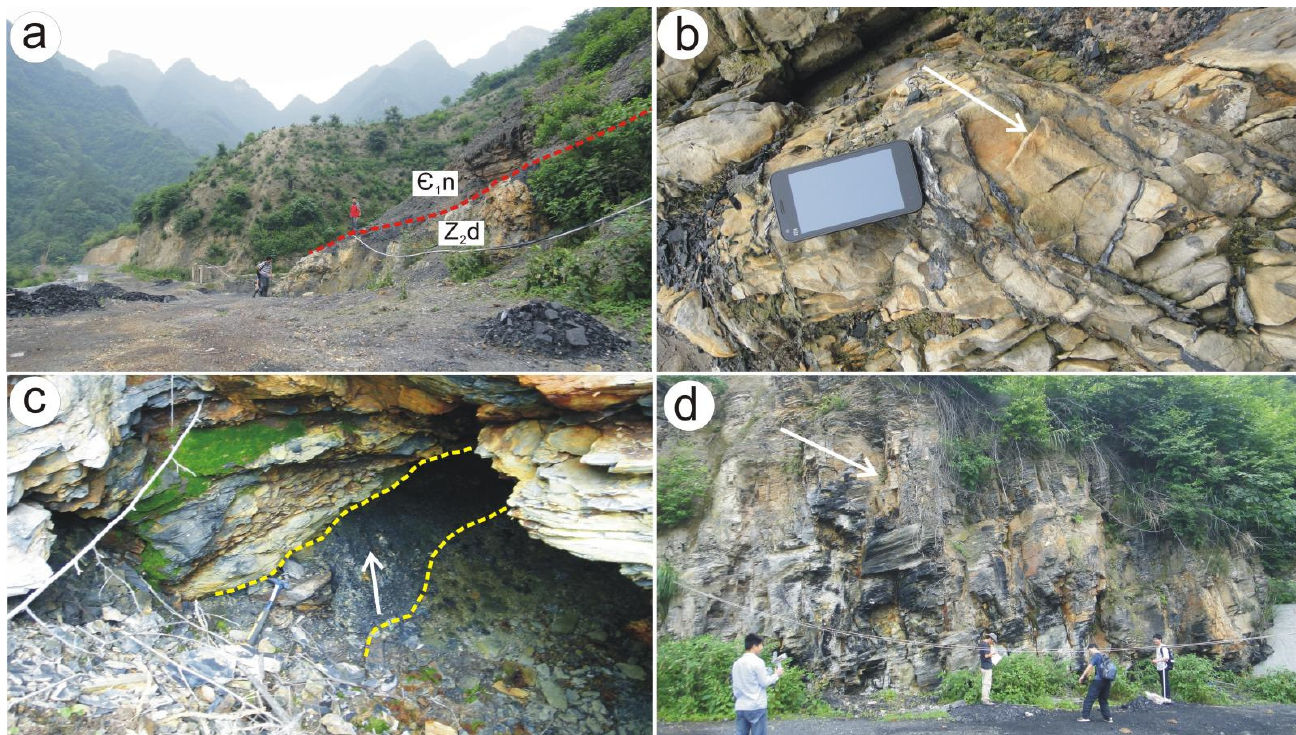
Figure 1. A schematic of the lithologic profile and sampling of the Baizhuyu deposit [30].